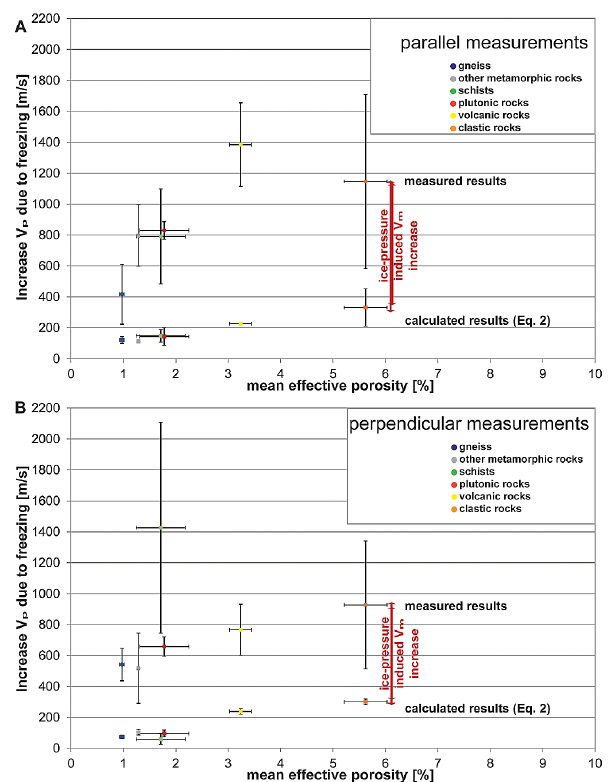
Fig. 3. P-wave velocity increase of samples in percent for rock groups classified based on lithology; (A) parallel to cleav- age/bedding and (B) perpendicular to cleavage/bedding; error bars indicate mean deviation.